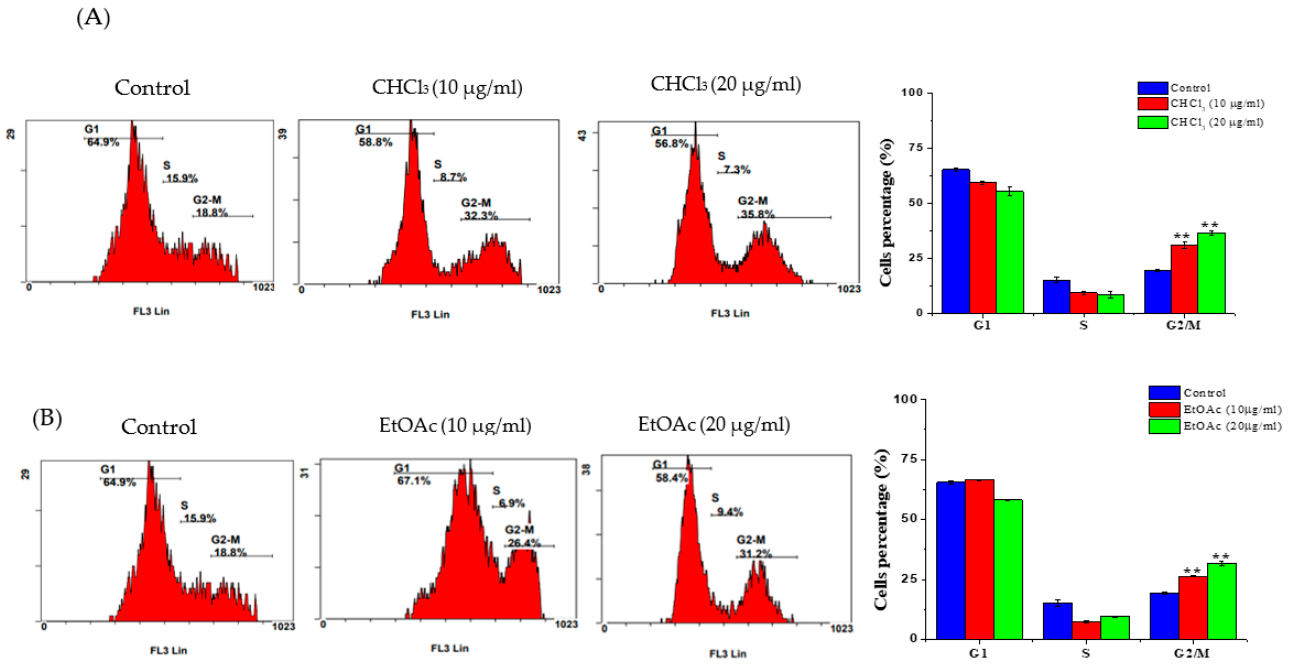
Figure 5. Cell-cycle progression of MCF-7 cells after exposure to ( A ) CHCl 3 and ( B ) EtOAc fractions of E. saudiarabica . The MCF-7 cells were treated with 10- and 20-µg/mL concentrations for 24 h and the distribution of cells in various stages was evaluated by measuring DNA content. Results showed that both fractions induced G2/M cell-cycle arrest in a dose-dependent manner. The experiments were performed in triplicate. Data are reported as Avg ± SD. ** p ≤ 0.01 vs. control.